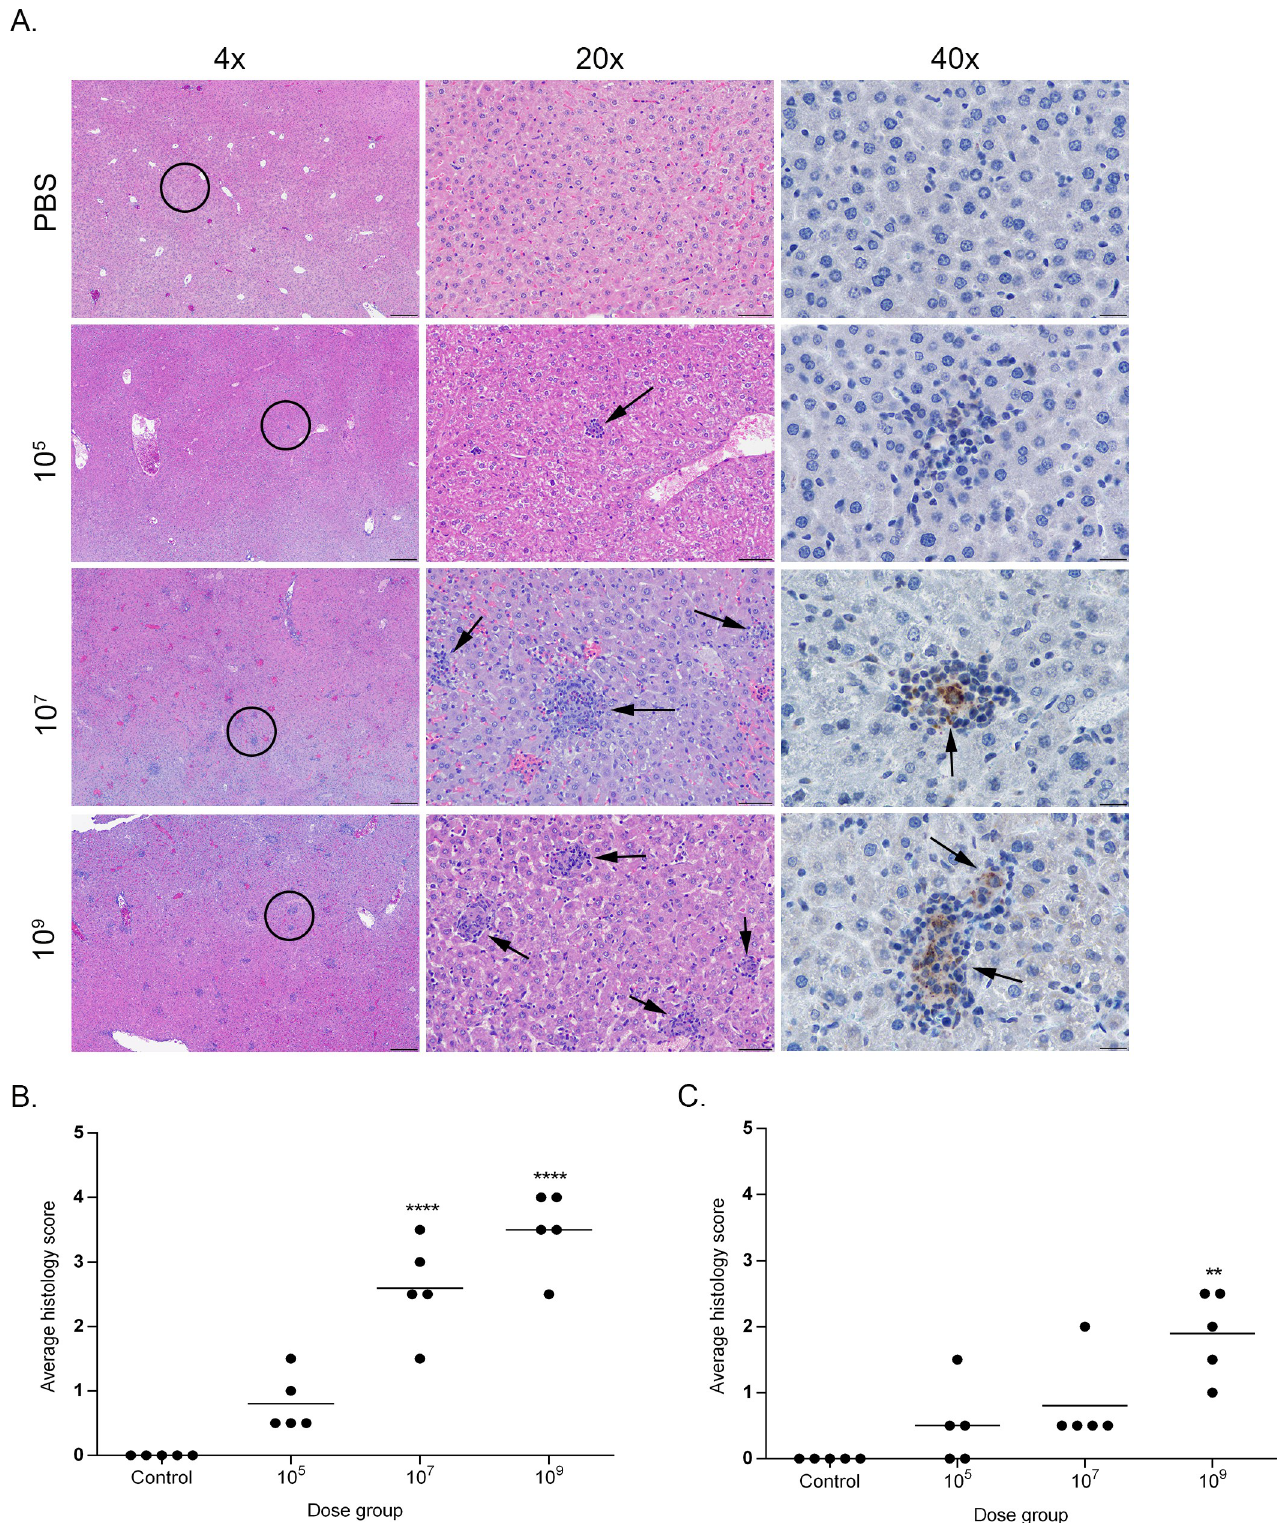
Fig 5. Histopathology of the liver in mice infected with B . canis . (A) Representative images of histopathology and immunohistochemistry of the liver of mice infected intraperitoneally with PBS (top row) or B . canis RM6/66 at a low dose (10 5 , second row), mid-range dose (10 7 , third row), or high dose (10 9 , bottom